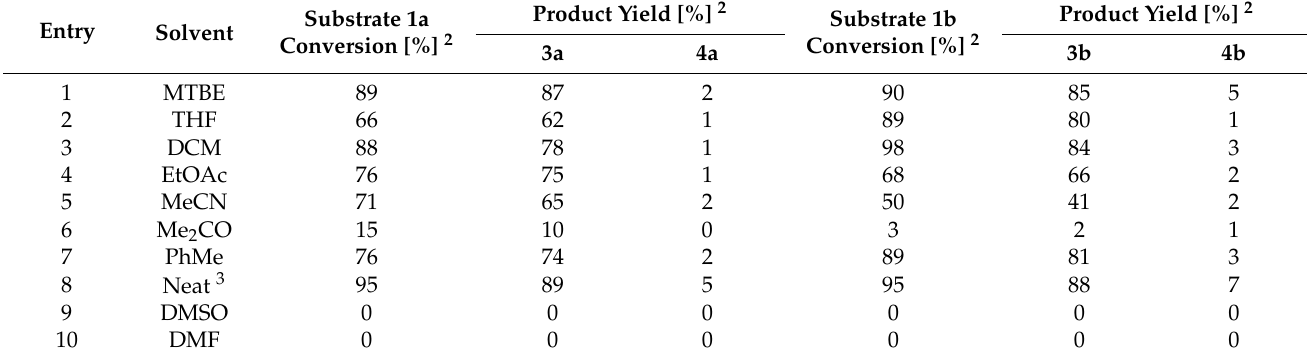
drop in reaction yield was observed with respect to MTBE while in the case of phenylphos- phonic acid 1b , the result was similar (Table 2, entries 1 and 2). In dichloromethane, conversion was high for acid 1a and almost quantitative for acid 1b , with good selectivity towards monoesters 3a and 3b (Table 2, entry 3). In ethyl acetate and acetonitrile, the con- versions were lower for both substrates (Table 2, entries 4 and 5). Acetone was found to be an inappropriate solvent with very low substrate conversion (Table 2, entry 6). The reaction proceeds effectively in toluene (Table 2, entry 7) but the highest conversion (95%) was observed when 2a was used as a reagent and solvent (Table 2, entry 8). No reaction progress was observed in experiments conducted in dimethyl sulfoxide and dimethylformamide (Table 2, entries 9 and 10). Table 2. The influence of a solvent on the substrate conversion and the selectivity of esterification reaction with triethyl orthoacetate ( 2a ); 1 Section 3.3.